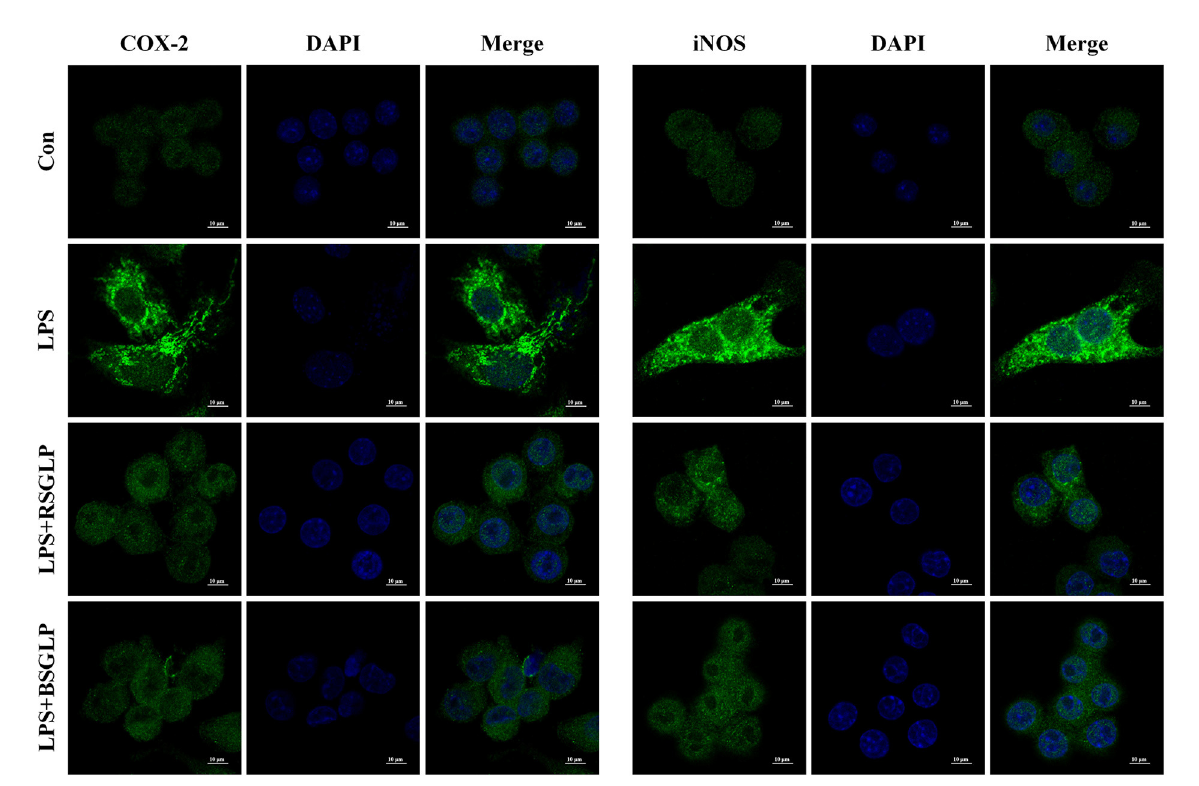
FIGURE9 Immunofluorescence staining of iNOS and COX-2 in RAW264.7 cells cotreated with LPS (1 µ g/mL) and RSGLP or BSGLP (both at 1.25